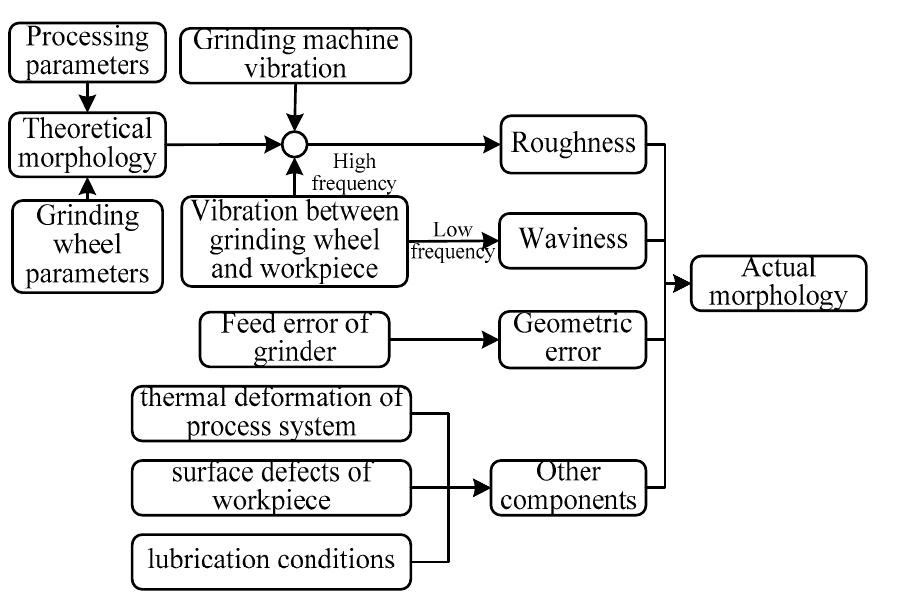
Figure 1. Causes analysis of surface topography in surface grinding.